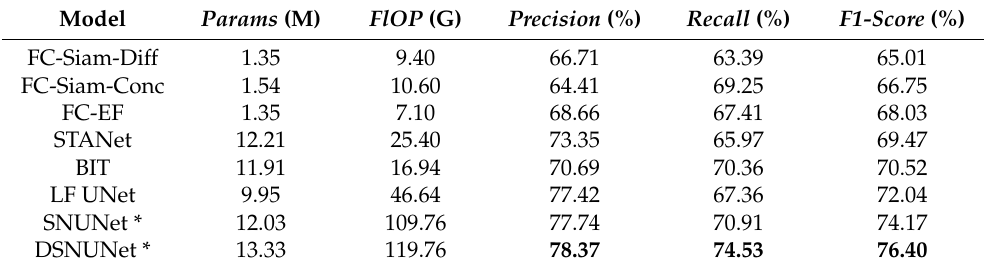
Table 3. Comparison of DSNUNet with other models based on optical images.